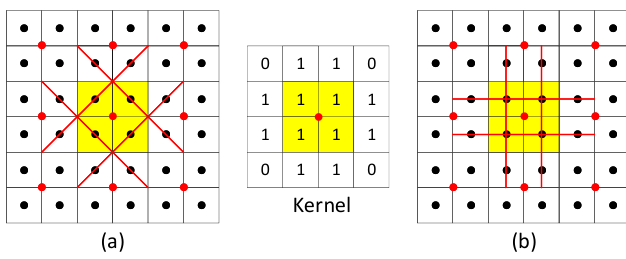
Figure 6. The #-filter method. ( a ) corresponds to Figure 5 (a1), and ( b ) to